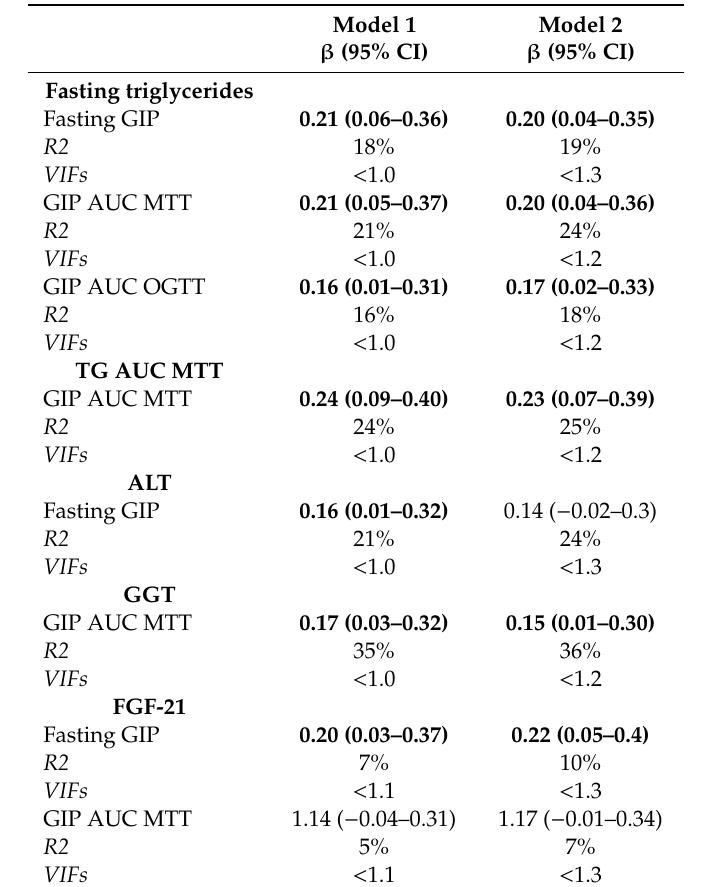
Table 2. Linear regression models of the association between fasting and postprandial GIP plasma level and fatty liver risk